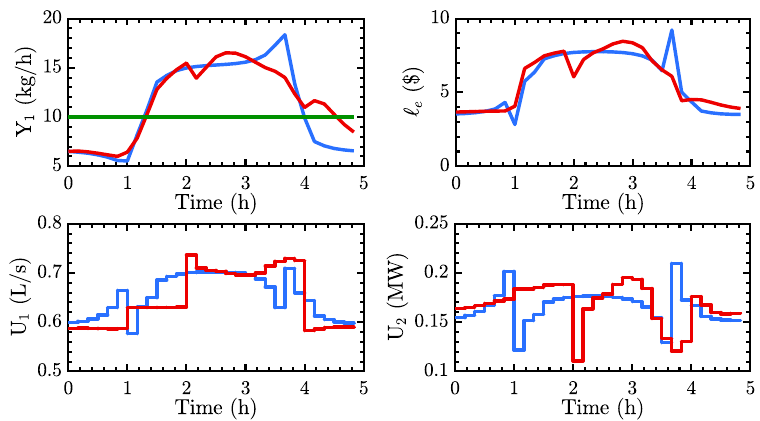
Figure 12. CO 2 emission, input and economic cost trajectories of the PCC plant for scenario 2 with carbon tax set at $200.00 per tonne CO 2 . EMPC (blue), MPC (red), Emission limit (green); ( top-left ) mass flow rate of CO 2 in the treated flue gas; ( top-right ) economic performance of controller; ( bottom-left ) volumetric flow rate of solvent; ( bottom-right ) heat input to reboiler.